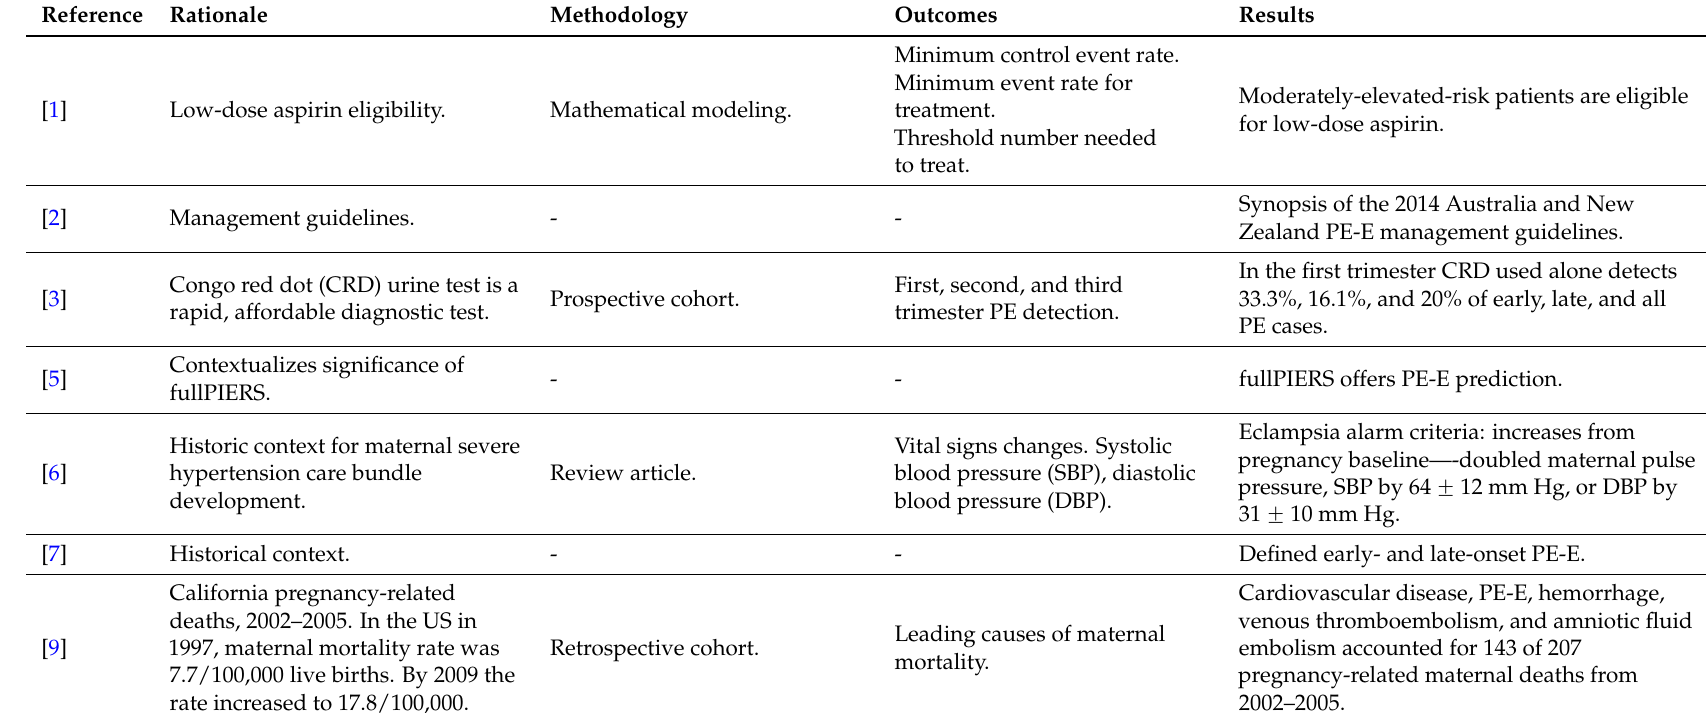
Table 1. Selected articles on preeclampsia-eclampsia (PE-E